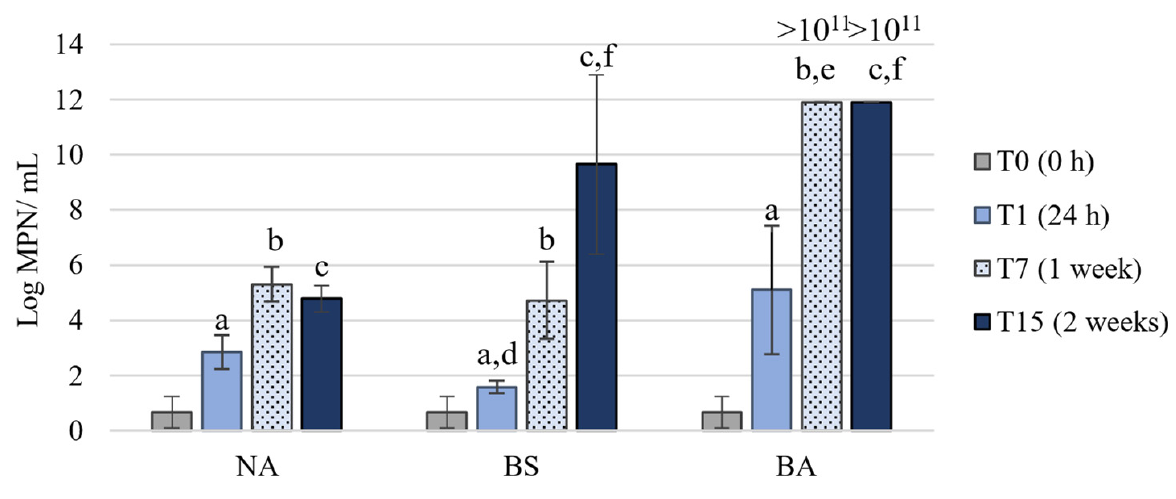
Figure 4. Abundance of hydrocarbons degraders, evaluated by the most-probable number (MPN) method, in the microcosm experiments (mean value, standard deviation, n = 3) with different treatments: Natural attenuation (NA), biostimulation (BS) and bioaugmentation (BA). a—significant differences between T1 and T0, for the same treatment; b—significant differences between T1 and T7, for the same treatment; c—significant differences between T1 and T15, for the same treatment; d—significant differences comparing all treatments with NA at T1; e—significant differences comparing all treatments with NA at T7; f—significant differences comparing all treatments with NA at